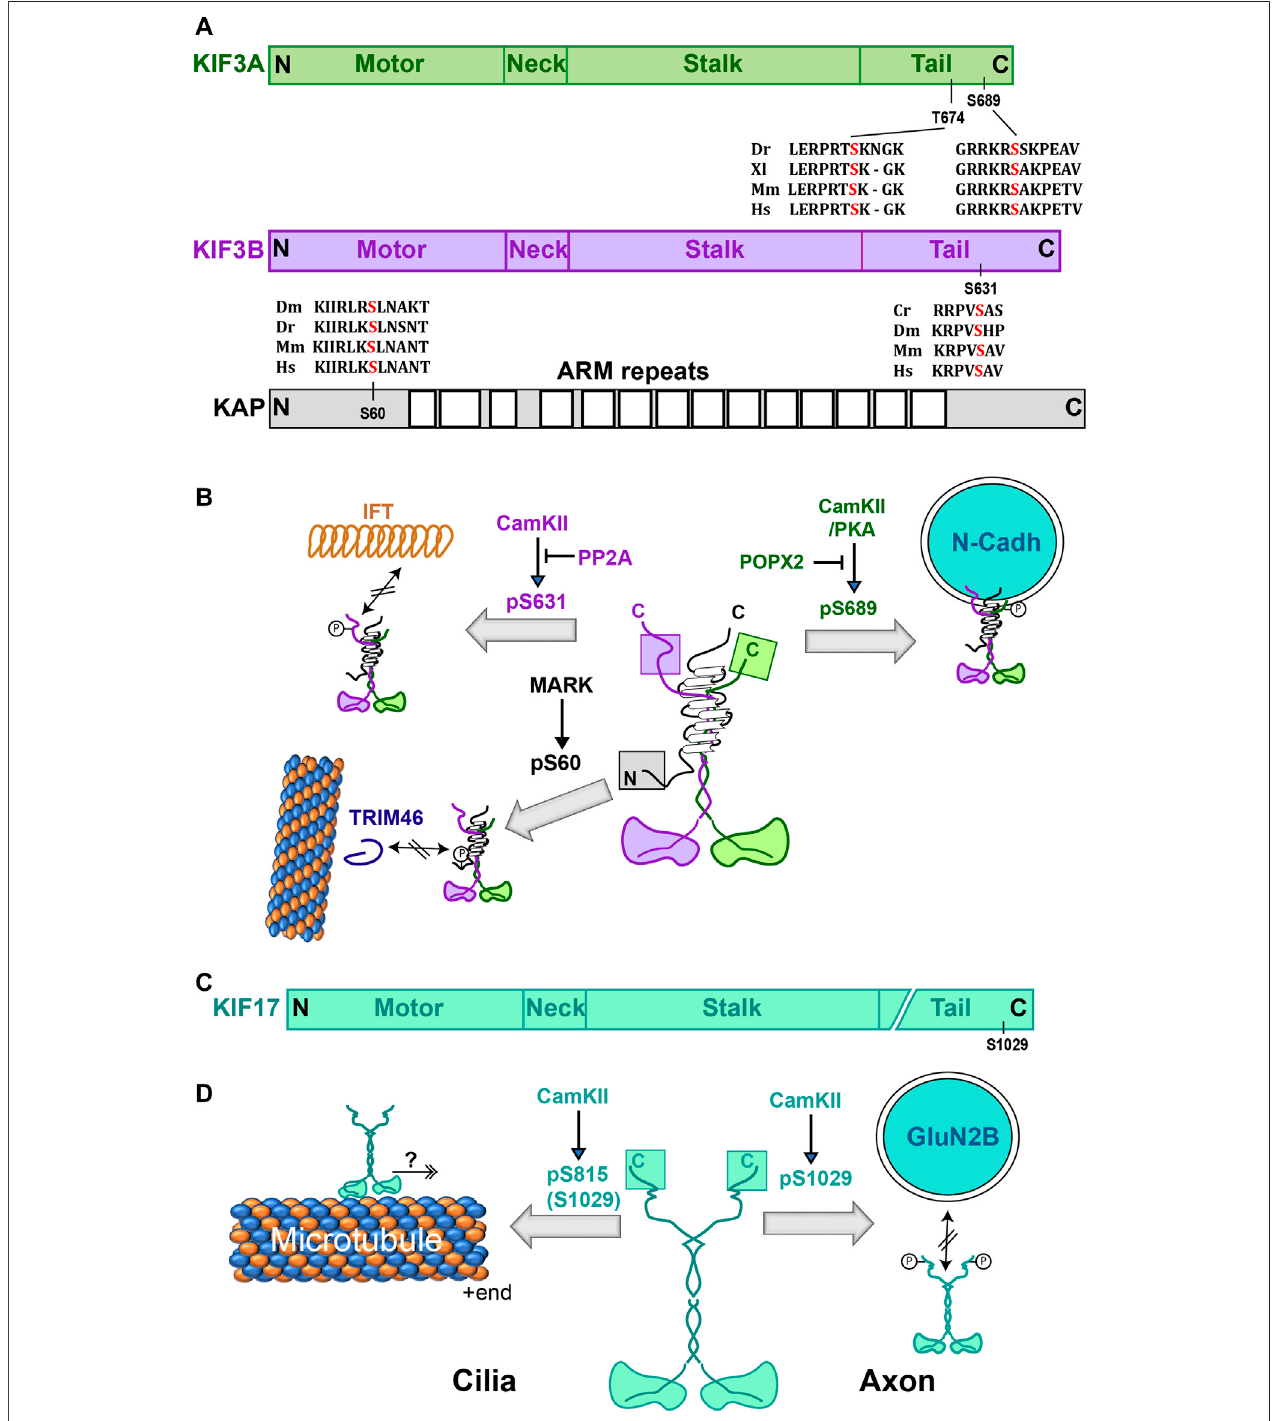
FIGURE 3 | Effect of phosphorylation on Kinesin-2. (A) Domain organizations of mammalian heterotrimeric Kinesin-2 subunits with relative positions of phosphorylation sites and alignments of the surrounding amino acid sequences from different species. Cr, Dm, Dr, Xl, Mm and Hs represent Chlamydomonas , Drosophila , zebra fi sh, Xenopus , mice, and humans. (B) Schematics indicate the structure of heterotrimeric Kinesin-2 holoenzyme and illustrate the effects of phosphorylationofdifferentserineresidues.PhosphorylationofthemotorsubunitsKIF3AandKIF3Bproducesoppositeeffects.TheKIF3A(S689)phosphorylation increases association with N-cadherin vesicles, whereas KIF3B(S631) phosphorylation disrupts interaction with the IFT particles. The KAP3(S60) Phosphorylation by MARK2 reduced the Kinesin-2 af fi nity for TRIM46 and microtubule. (C) Domain organization of the mammalian homodimeric Kinesin-2 subunit with the relative position